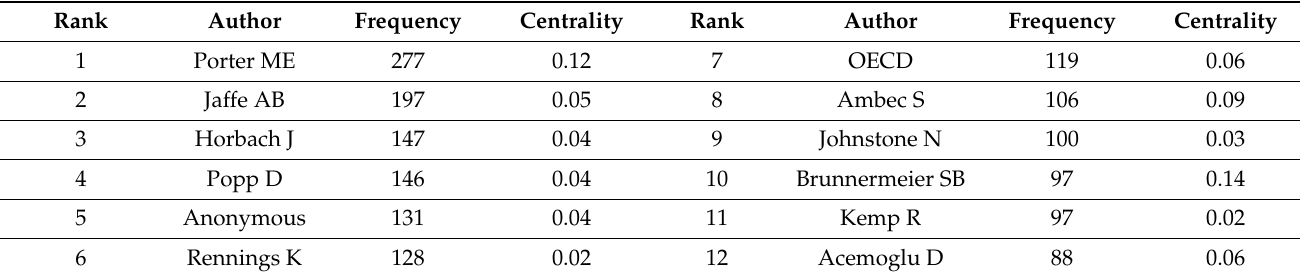
Figure 4. CiteSpace-based author co-citation mapping. Table 3. Frequency of TOP 12 co-cited authors.